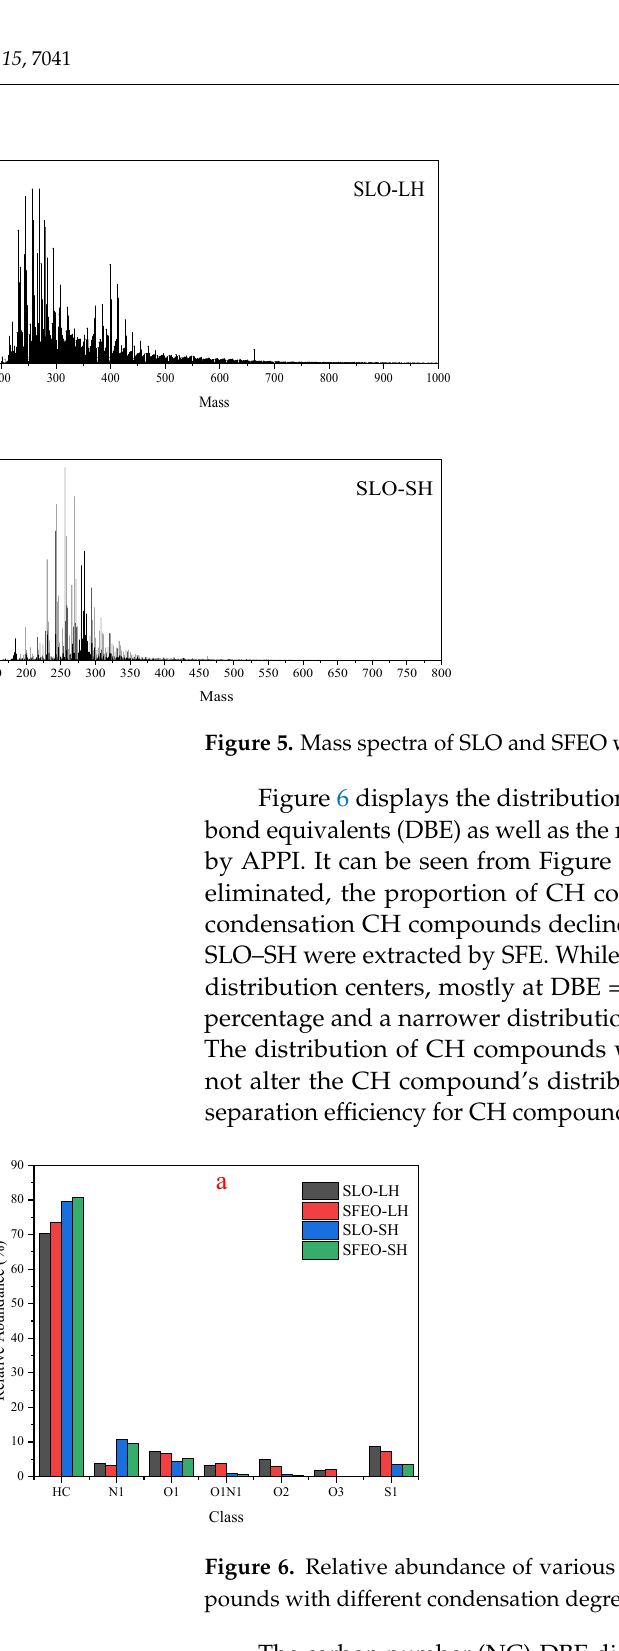
Figure 7. NC-DBE distribution of compounds in SLO–LH and SFEO–LH (APPI). (NC, number of carbon; DBE, double bond equivalents,The NC regions of CH, O1 and S1 compounds are demar- cated at 26, 22, and 20, respectively. The DBE regions of CH, O1, and S1 compounds are demarcated at 10. For example, CH compounds in the A region (NC < 26 and DBE > 10)).